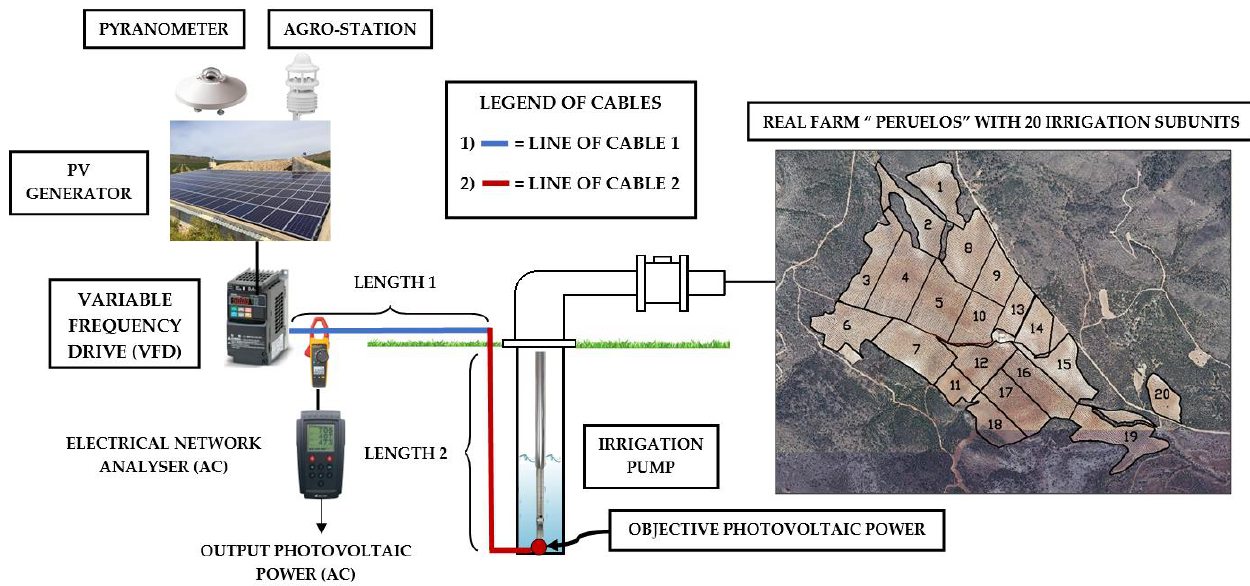
Figure 1. General description of the main equipment used and installed in this case study.